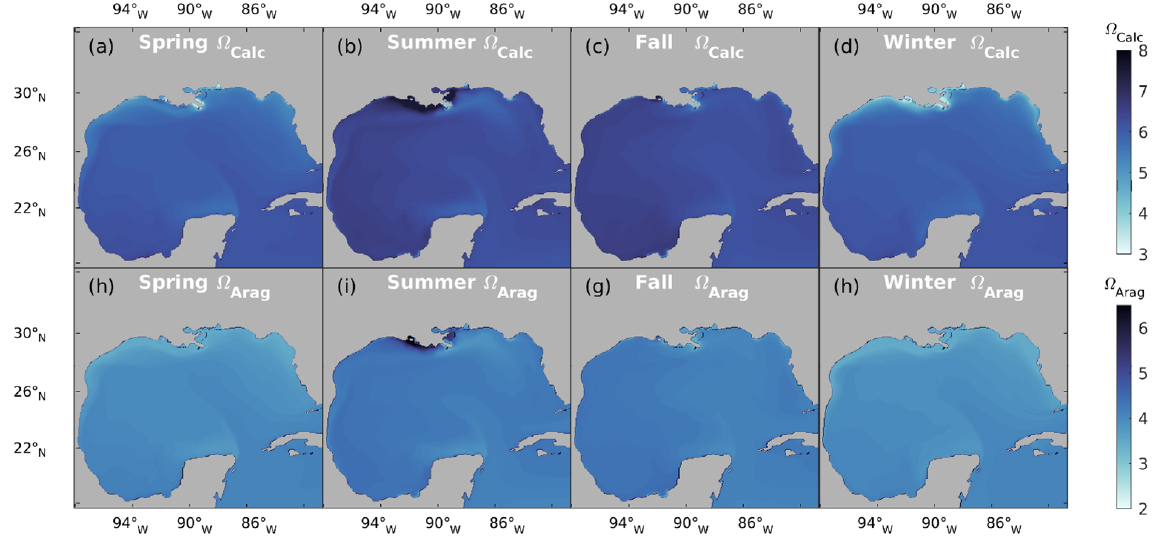
Figure 10. Seasonal mean sea surface (cid:127) Arag and (cid:127) Calc over